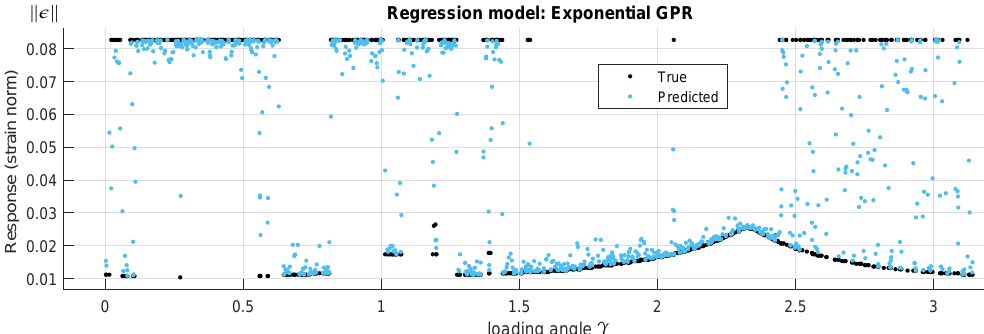
Figure 10. True and predicted response using an Exponential Gaussian Process Regression (GPR) deep learning